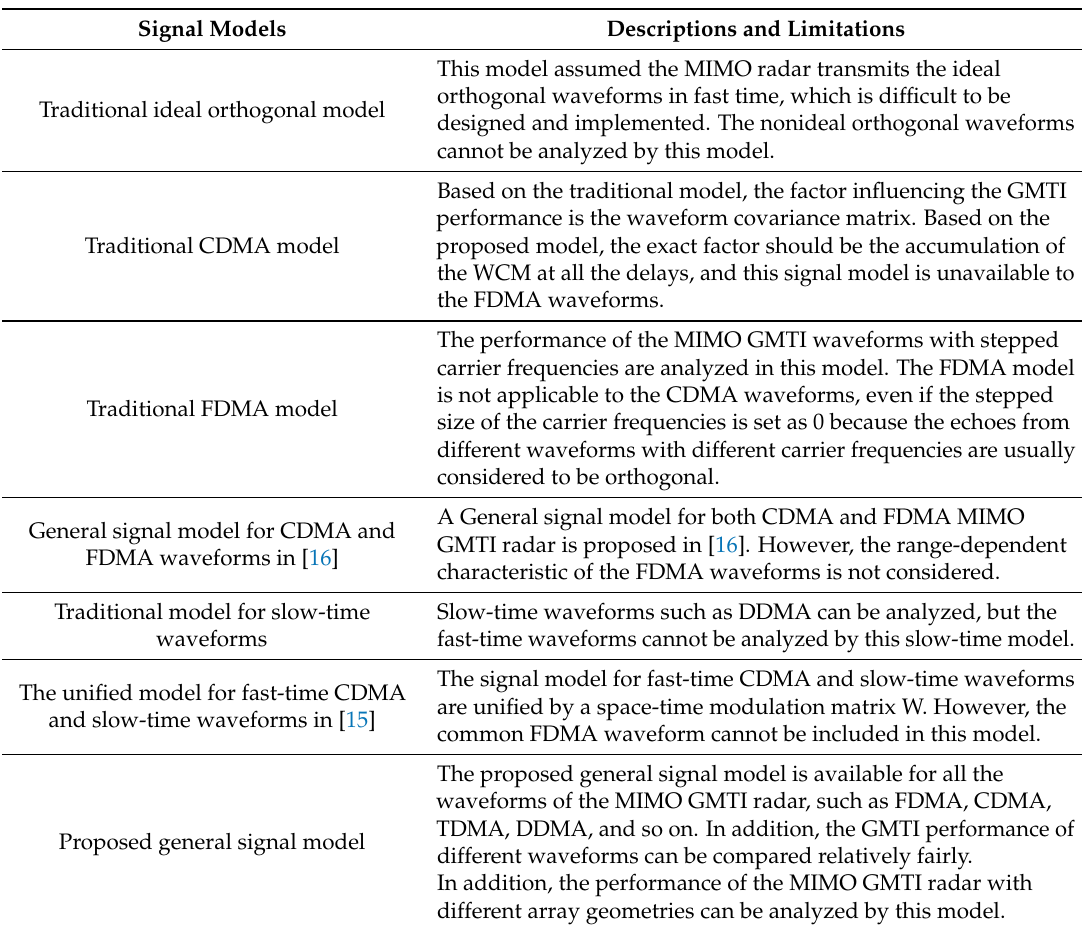
Table 2. The comparison of the different signal